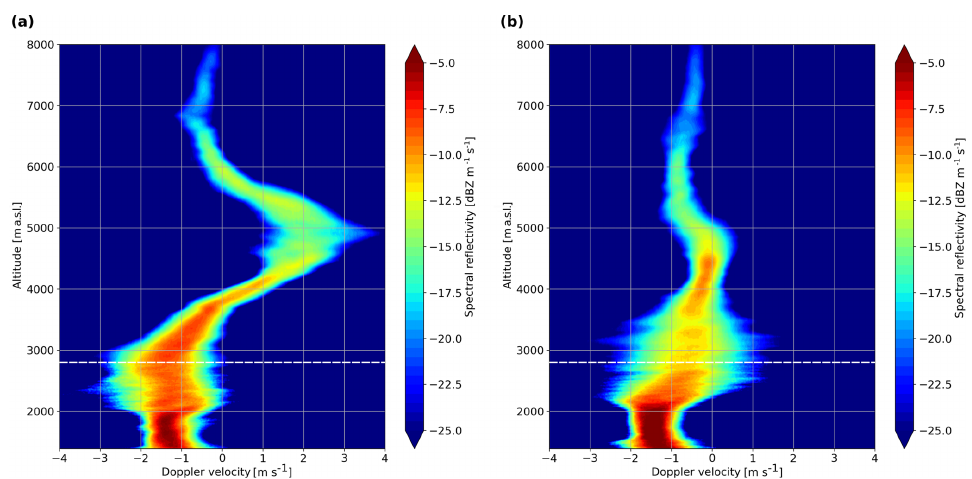
Figure 13. Range spectrogram from WProf averaged (a) from 07:42 to 07:47UTC and (b) from 07:57 to 08:02UTC. Positive velocity values represent upward motions. The dashed white line shows the lower limit of the WCB (black contour in Fig. 5a, b, c).